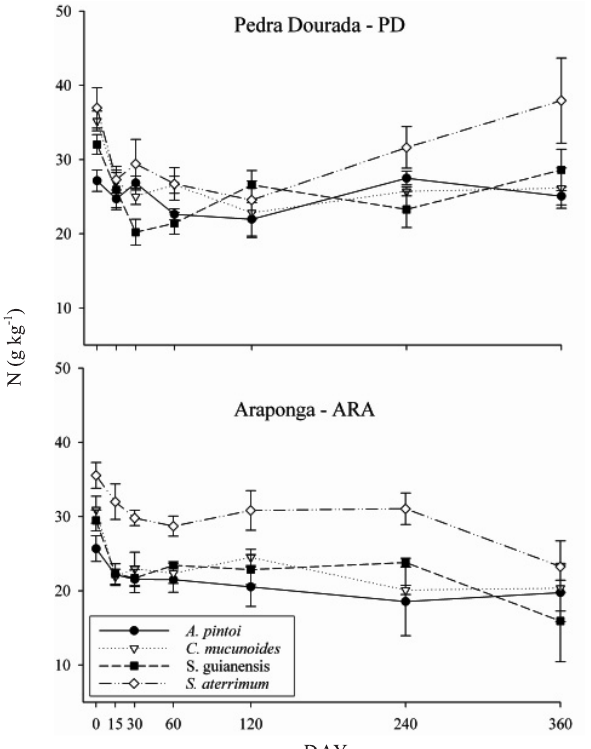
Figure 4. Nitrogen concentration of different leguminous plants, in 360 days in Pedra Dourada and Araponga. Vertical bars represent standard error (n =